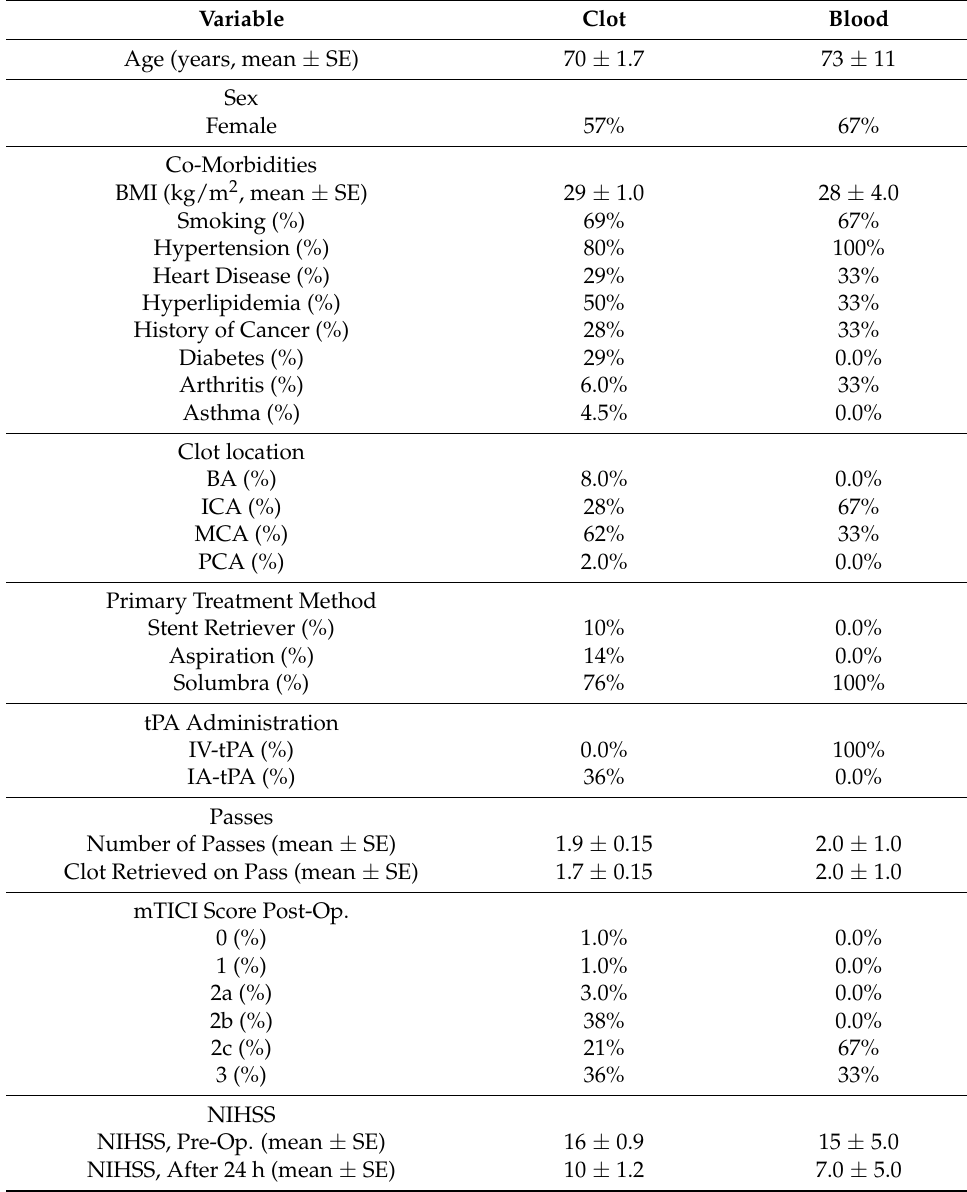
Table 1. Description of patient population